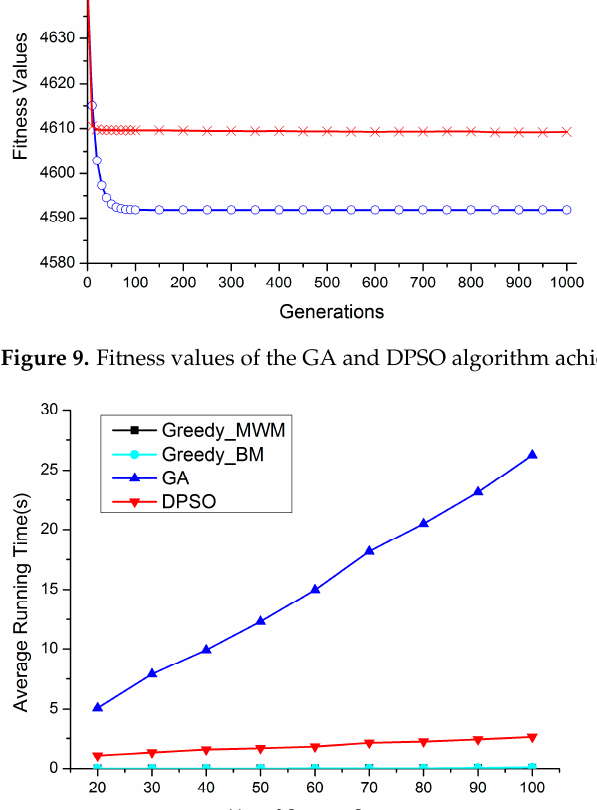
Figure 9. Fitness values of the GA and DPSO algorithm achieve over 1000 generations when n = 60.